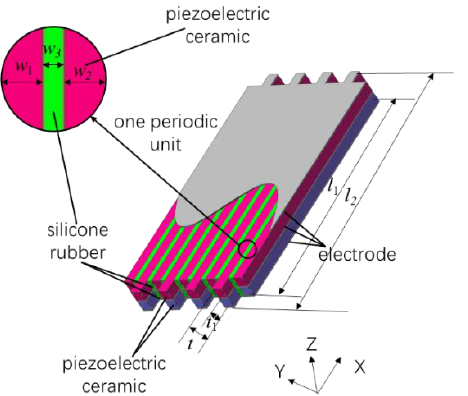
Figure 2. The geometry of double-harmonic piezoelectric composite lamination.